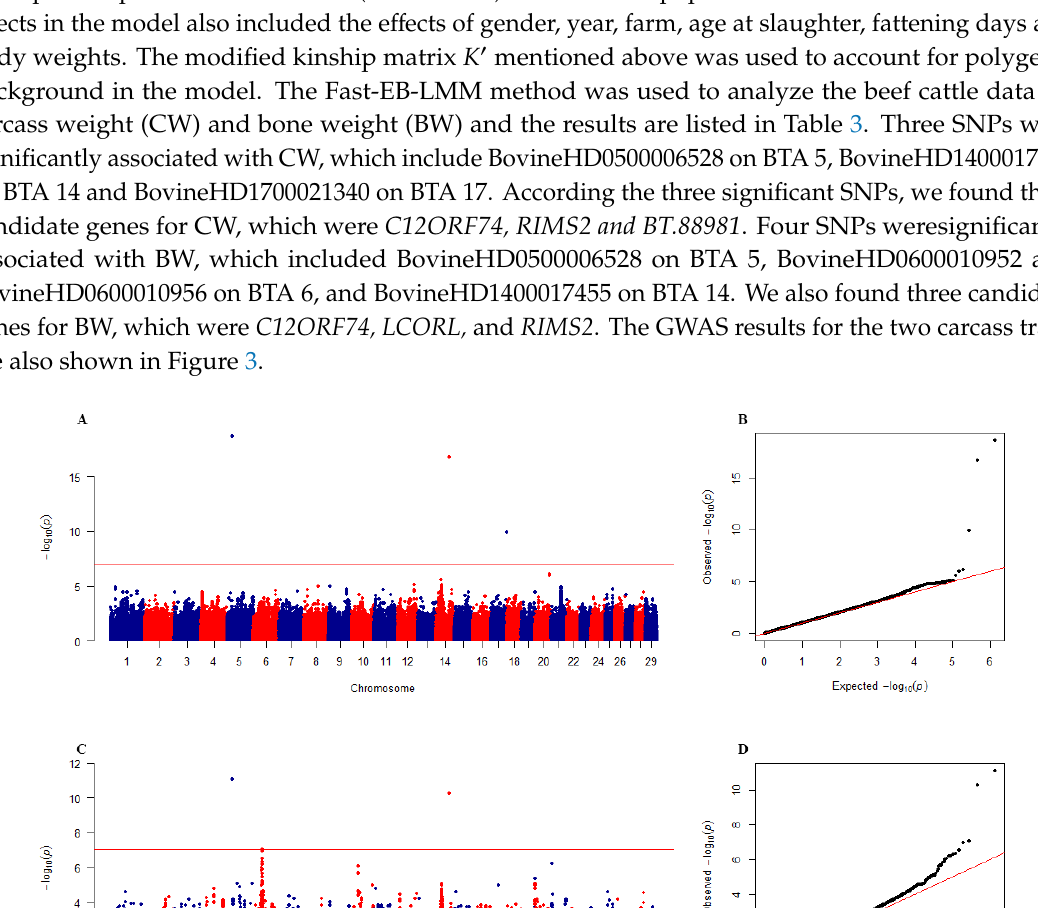
Table 3. Significant SNPs and candidate genes identified by the Fast-EB-LMM method for carcass weight (CW) and bone weight (BW) in the Chinese Simmental beef cattle population.